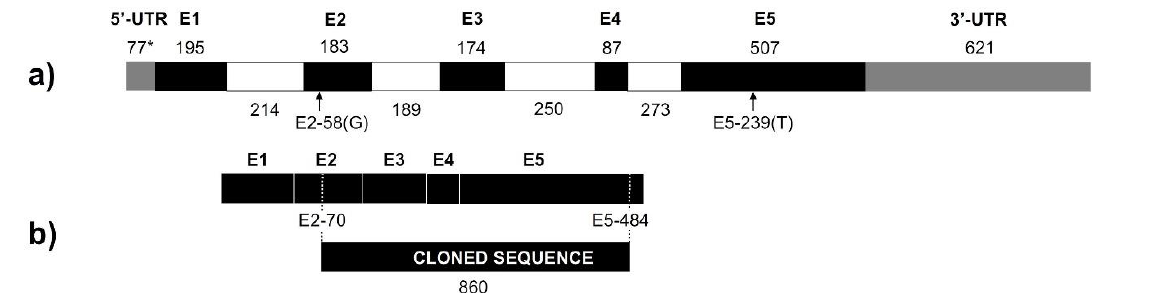
Figure 6. ( a ) Corrected structure of the predicted CaPCS2 gene. Composition of exons (black, numbered E1, E2, etc.), untranslated regions (gray), and introns (white) is given in bp and drawn to scale. An asterisk indicates at least one of the base pair deletions that were erroneously present in the sequence previously described in Olsson et al., 2017 [9], the missing base is indicated in parentheses. ( b ) Coding region of the predicted CaPCS2 ( top ) and the region cloned in E. coli ( bottom ).